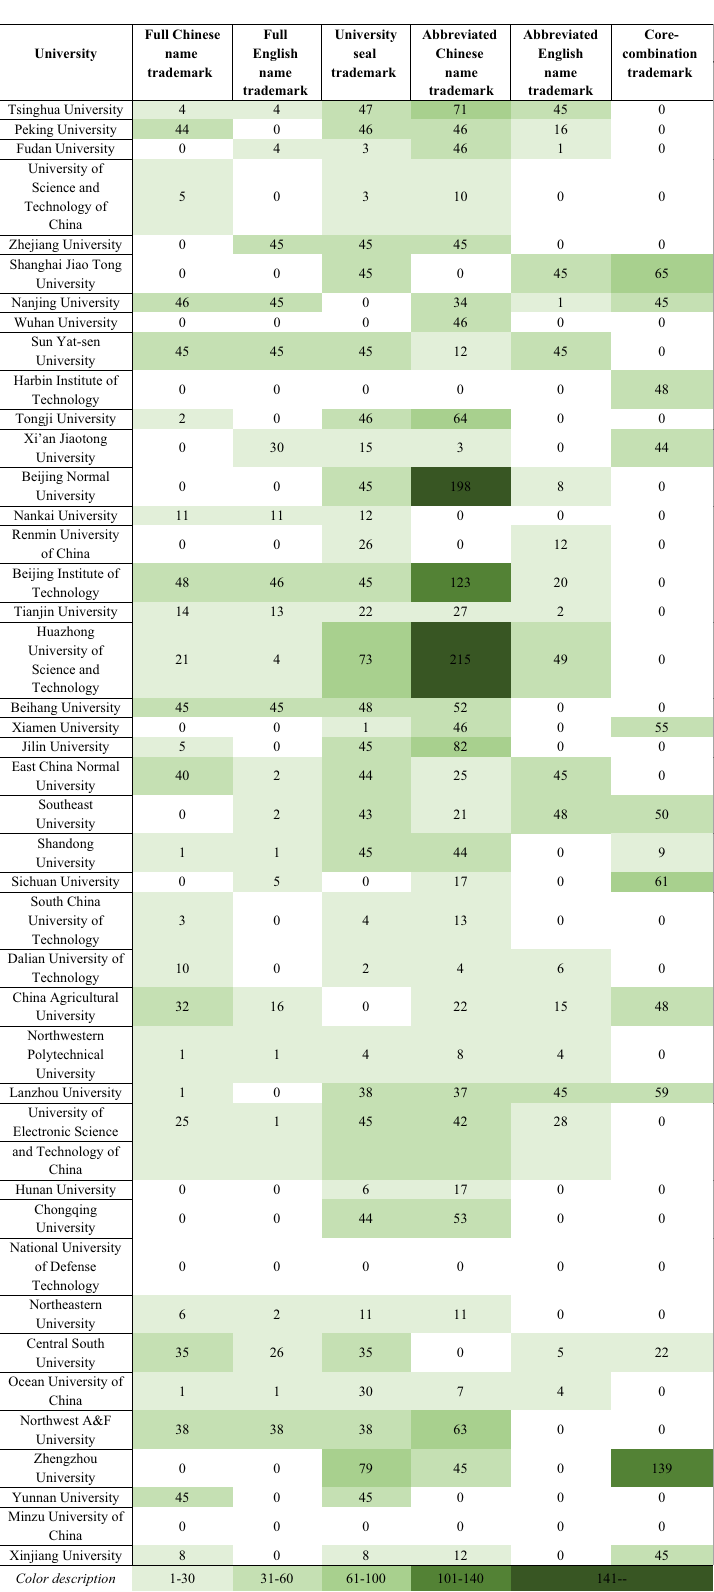
Table 1 Distribution of core trademarks of the 42 fi rst-class